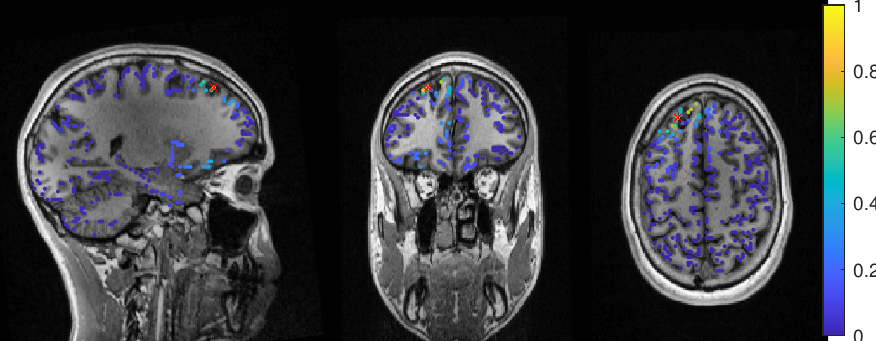
Figure 10. Patient 2’s result of the EEG 6 compartment event-related beamformer at 0.02 regularization with sagittal ( left subfigure), coronal ( middle subfigure) and axial ( right subfigure) cuts through T1 MRI and source space. The maximum is additionally marked with a red x. Note that the MRI is not in radiological